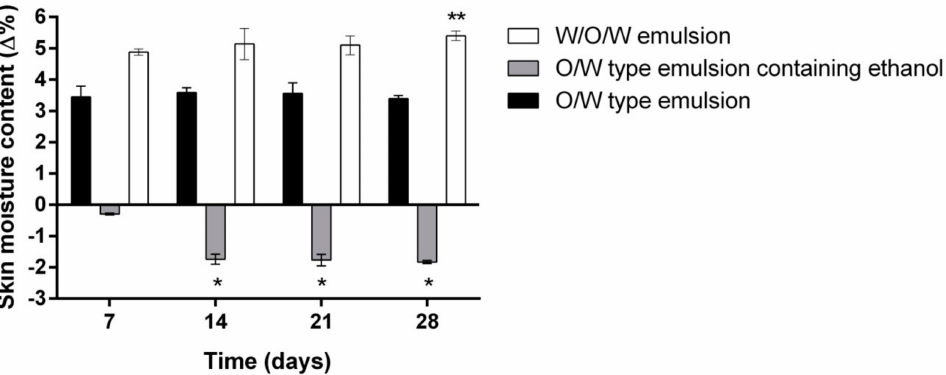
Figure 3. The influence of the investigated emulsions on the skin moisture within 28 days. * p < 0.01 vs. O/W emulsion and W/O/W emulsion; ** p < 0.01 vs. 7 days. N = 42